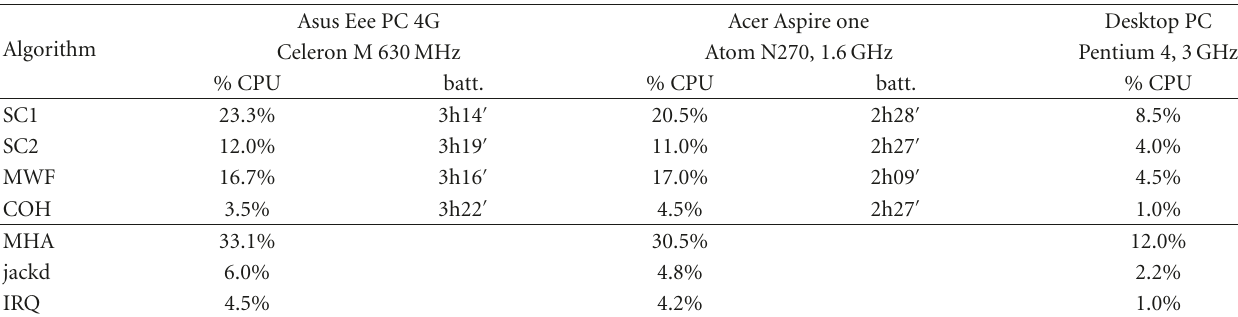
Table 1: Performance of the PHS prototype system. In addition to the algorithm CPU time, the CPU time used for signal routing, resampling, overlap-add, spectral analysis, and hearing loss correction was measured (labelled MHA), and also the CPU time used by the jackd sound server and the sound card interrupt handler.